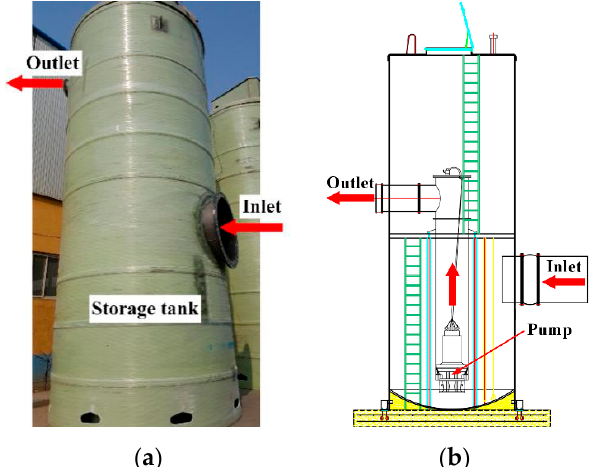
Figure 1. Storage tank of the prefabricated pumping station: ( a ) image; ( b ) schematic view of major components in the tank.